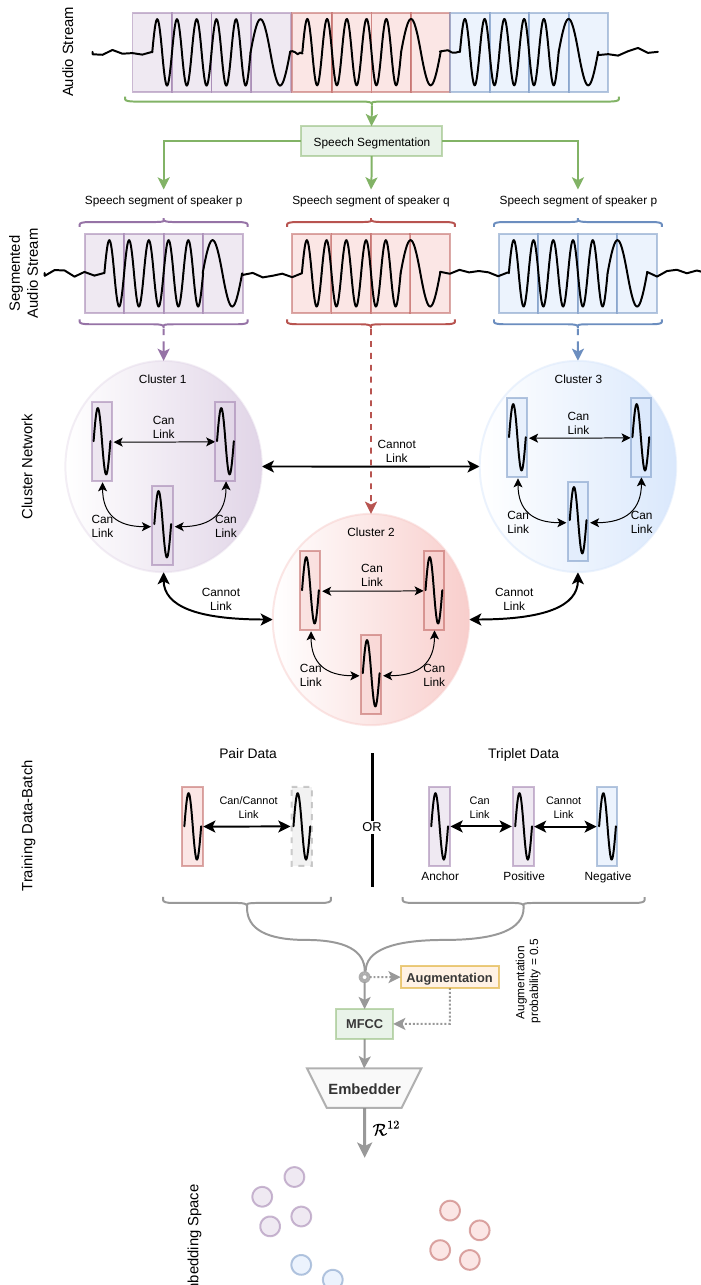
Figure 2. The figure illustrates the comprehensive procedure to generate u-vectors. Audio stream is segmented and given pseudo labels. Then a cluster network is formed using small non-overlapping speech frames from the speech segments. Finally, training data is generated from the cluster network based on the needs of the siamese architecture. The pairwise network requires an equal number of can-link and cannot link pairs. In contrast, triplet networks receive three data, one pair with can-link, and one cannot-link pair. The network/embedder is trained on randomly augmented speech frames, further converted into 2D feature maps using MFCC. While training, the embedder reforms the cluster associations, where speaker similarity is